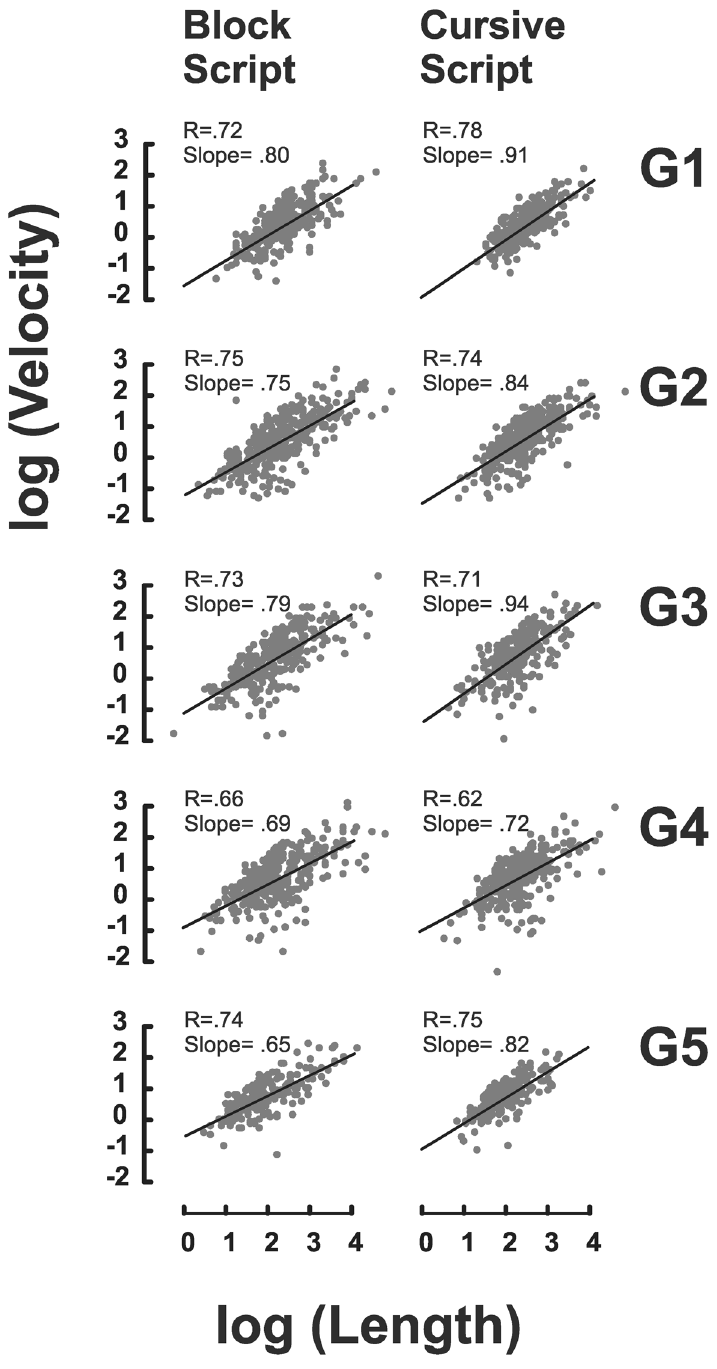
Figure 3. Isochrony is invariant across school grades. The log-log plot (natural logarithm) of length (cm) against mean velocity (cm/sec) is reported for each group of children - when writing in block and cursive scripts. Each data point represents the word burle written in one of the experimental conditions ( Spontaneous , Big , and Fast ) by each individual participant. In line with Isochrony, the mean velocity presents a strong positive correlation with the linear extent of the corresponding trajectory for each group of